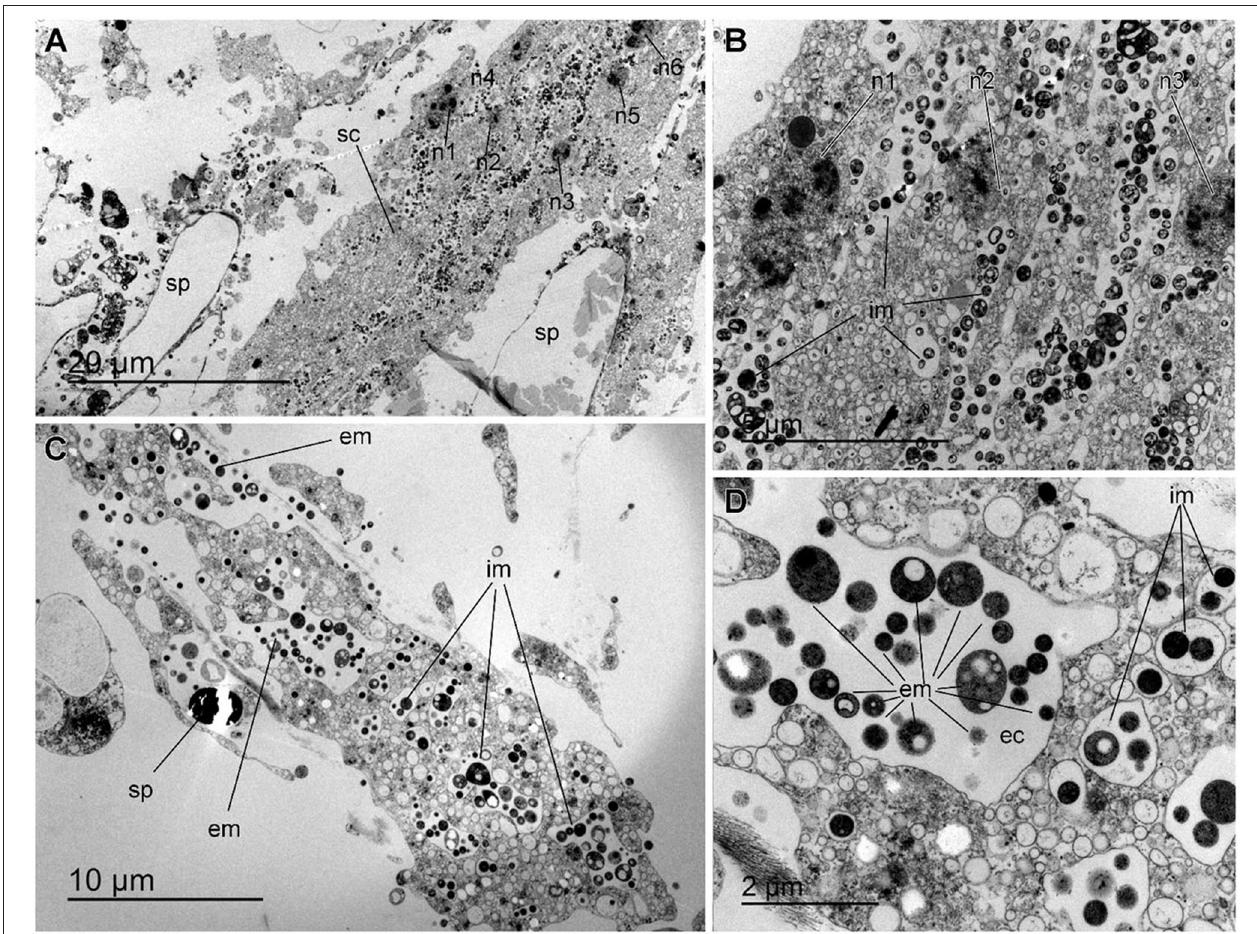
FIGURE 9 | Bacteriosyncytia in Vazella pourtalesii . (A) Partial general view of a bacteriosyncytium (sc) in which six nuclei (n1 to n6) can be seen, along with many intracellular microbes (im). The cell is in a tissue zone where the whole of two large spicules (sp) occurred before we desilicified them for tissue sectioning. (B) Enlargement of a zone of the Figure 8A in which nuclei n1 to n3 can be seen along with large abundance of intracellular microbes within membrane-bound vesicles. (C) Partial general view of bacteriosyncytium, showing abundant intracellular microbes (im), along with abundance of extracellular microbes (em), which proliferate around the syncytium and particularly in the valleys formed by the pseudopodia of the bacteriosyncytium. Because this tissue was not desilicified for sectioning, remains of a silica spicule (sp) can be seen by the side of the bacteriosyncytium. (D) Enlargement of Figure 8C detailing the variety of sizes and ultrastructure of intracellular microbes (im) within membrane bound vesicles in the cytoplasm of the bacteriosyncytium. Note the presence of extracellular microbes (em) in a large extracellular cavity (ec) formed among the pseudopodia of the